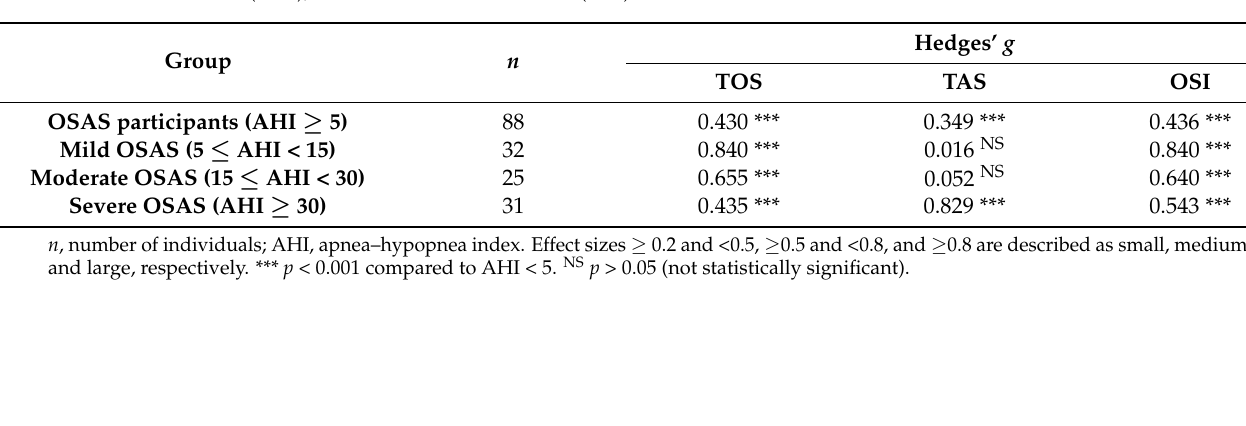
Figure 2. Total oxidative status (TOS) of the uvular mucosa of the participants with obstructive sleep apnea syndrome (OSAS) and in non-OSAS participants. Data represent median, 25–75% confidence interval, as well as minimum and maximum. * p < 0.05, ** p < 0.01 compared to apnea–hypopnea index (AHI) < 5. ↑ —increase compared to AHI < 5. Table 5. Hedge’s g measurement of the effect sizes for the difference in the values of total oxidative status (TOS), total antioxidative status (TAS), and oxidative stress index